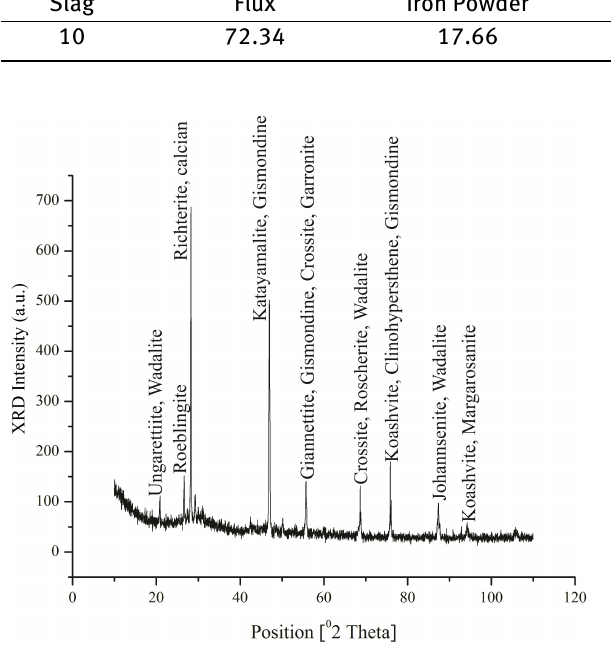
added during the agglomeration process in the formula- tion of fluxes. Fe is also observed in some phases which is indicated from the iron powder during mixing of flux